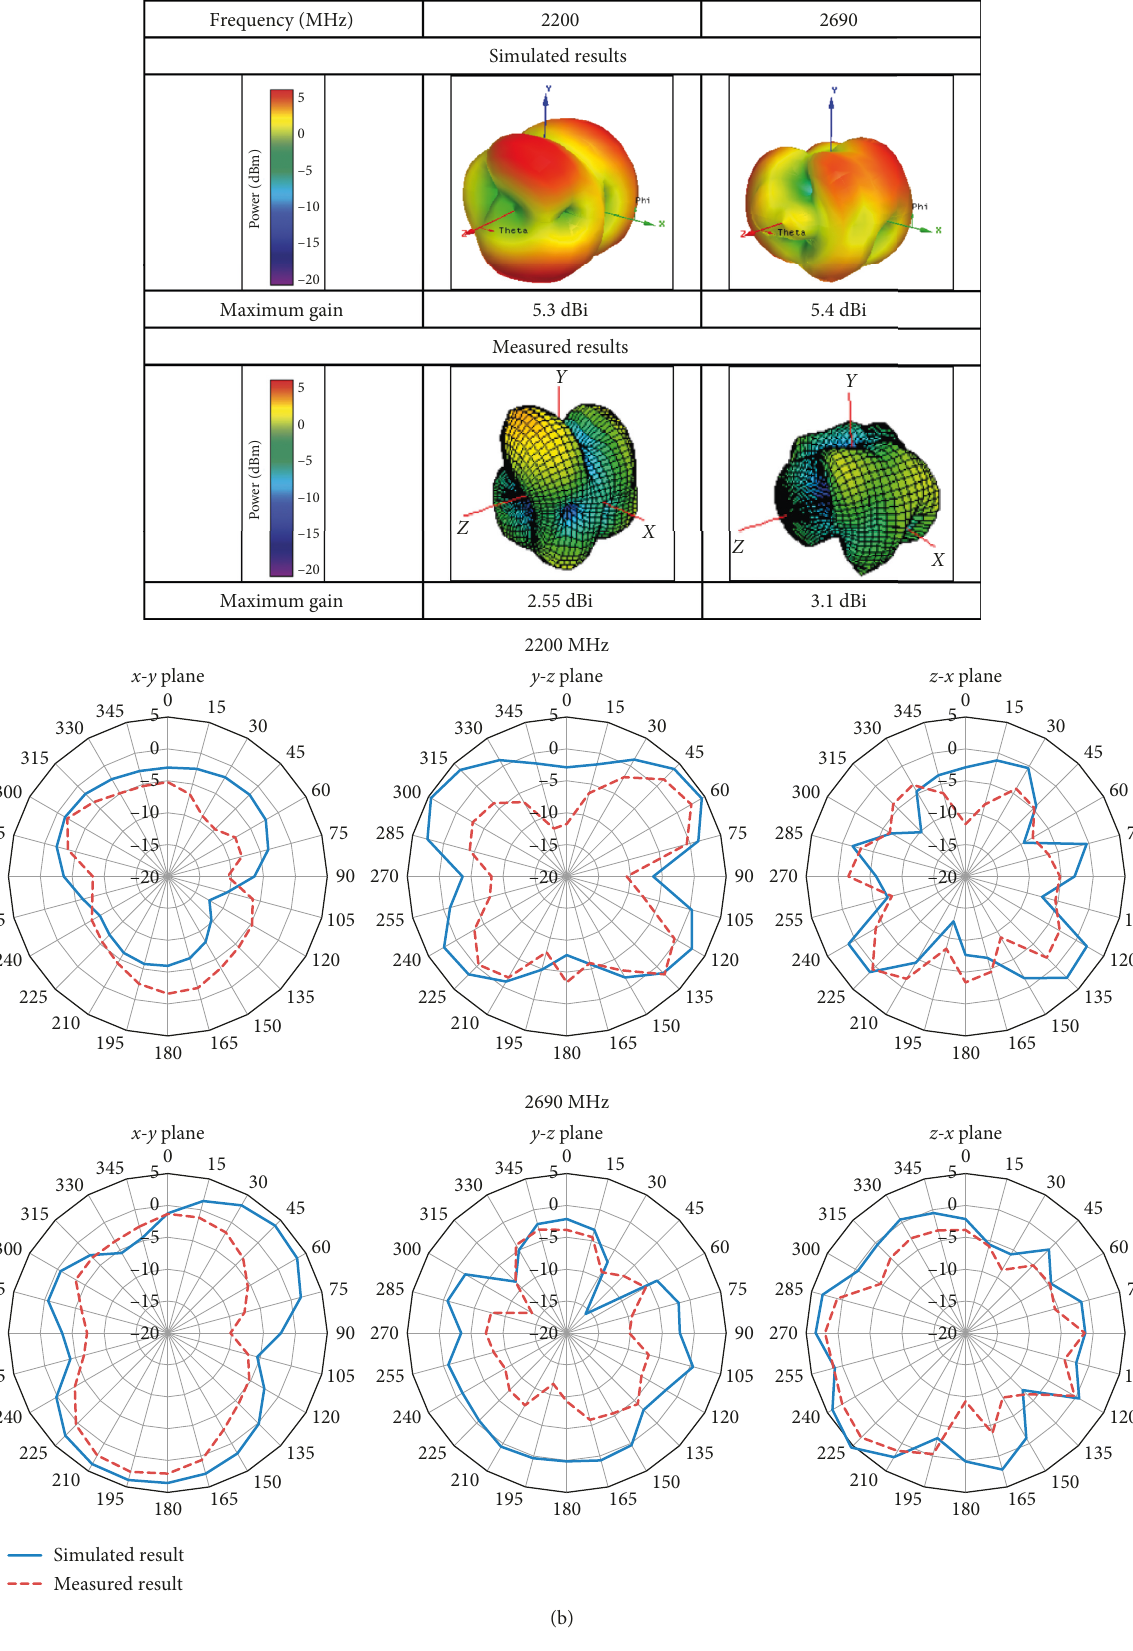
Figure 3: Simulated and measured 2D and 3D radiation patterns of #1. (a) Lower-operating band. (b) Upper-operating